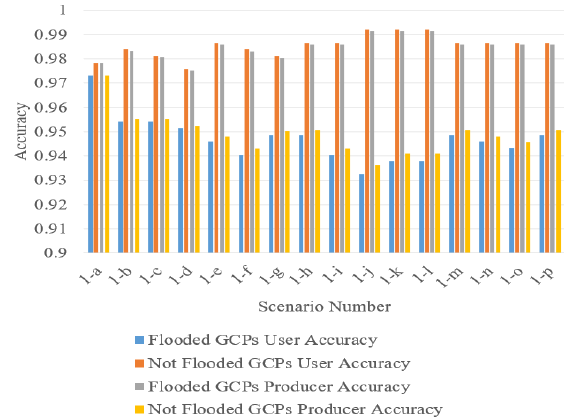
Figure 6. User and producer accuracy of flooded and not- flooded sample points in the first series of